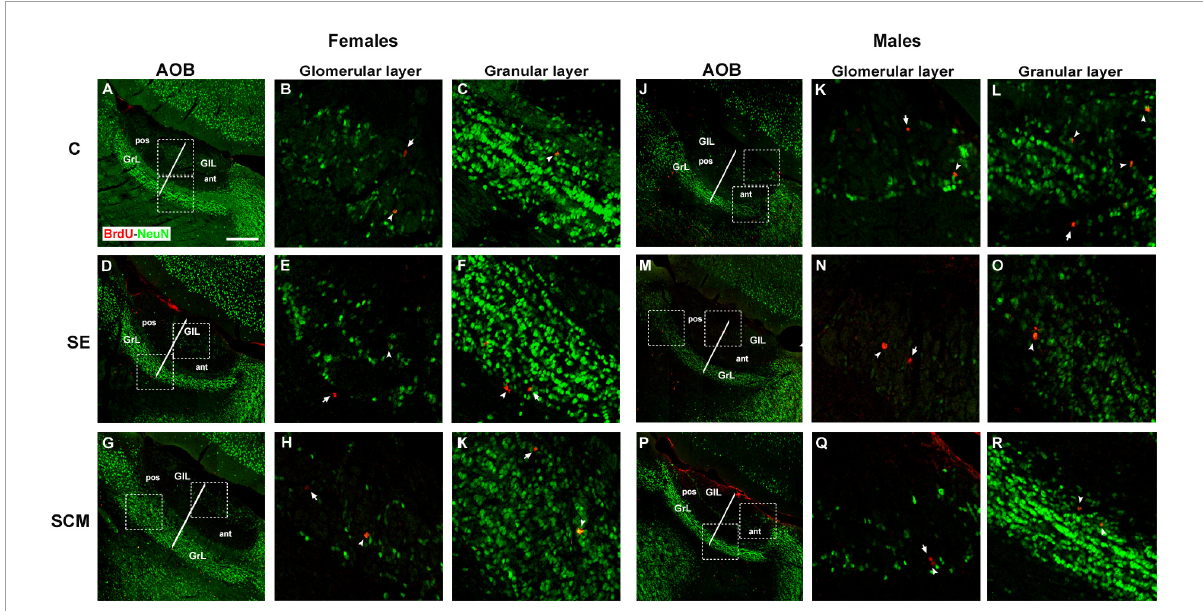
FIGURE5 Representative photomicrographs of new neurons that arrive and survive in the accessory olfactory bulb (AOB) after mating and social exposure in female and male prairie voles Photomicrographs of double immunolabeling for BrdU (red; new cells) and NeuN (green; mature neurons) in the glomerular and granular cell layers. (A–C) Control (C), (D–F) social exposure (SE), and (G–I) social cohabitation with mating (SCM) females; (J–L) C; (M–O) SE and (P–R) SCM males. Scattered square: enlargement of the inset at 20 × . White arrowheads: BrdU/NeuN-positive cells. White arrows: non-neuron BrdU-positive cells localized in the glomerular and granular cell layers (GlL and GrL, respectively). ant, anterior; pos, posterior. 20 × . Scale bar: 100 µ m.